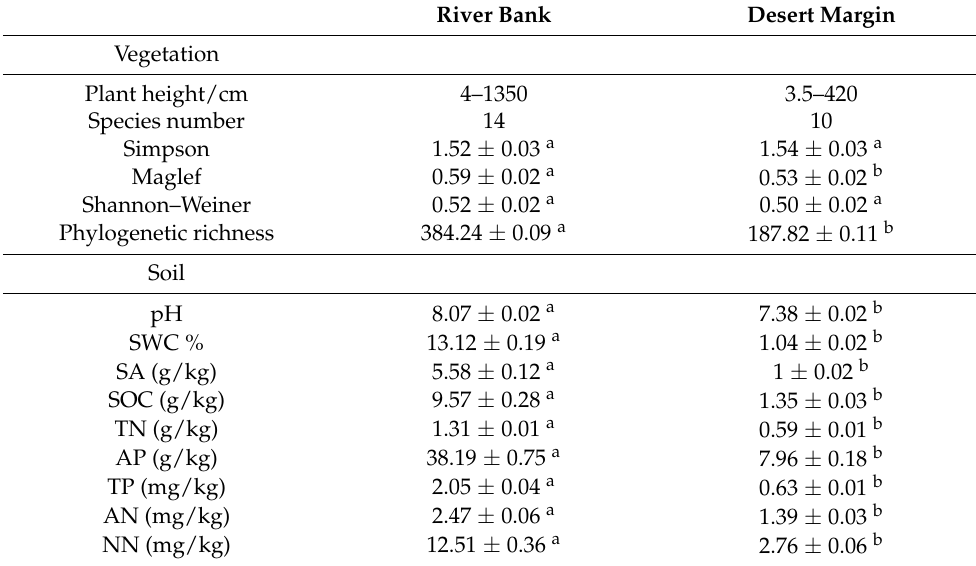
Table 1. The vegetation and soil